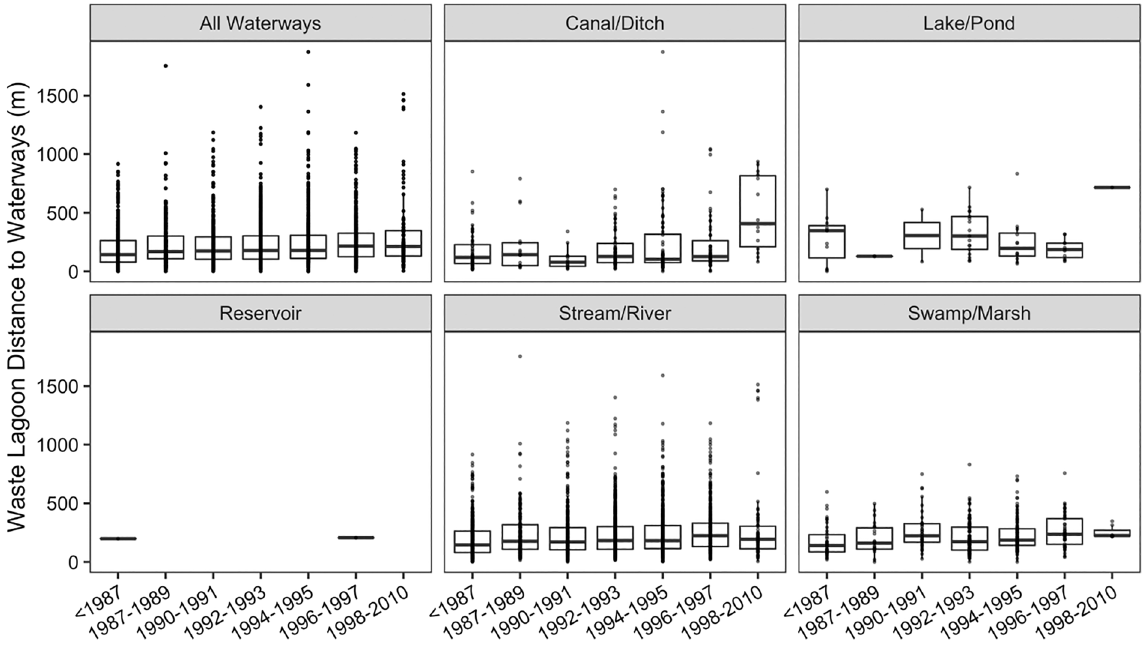
Figure 9. Nearest water features distance to swine waste lagoons.